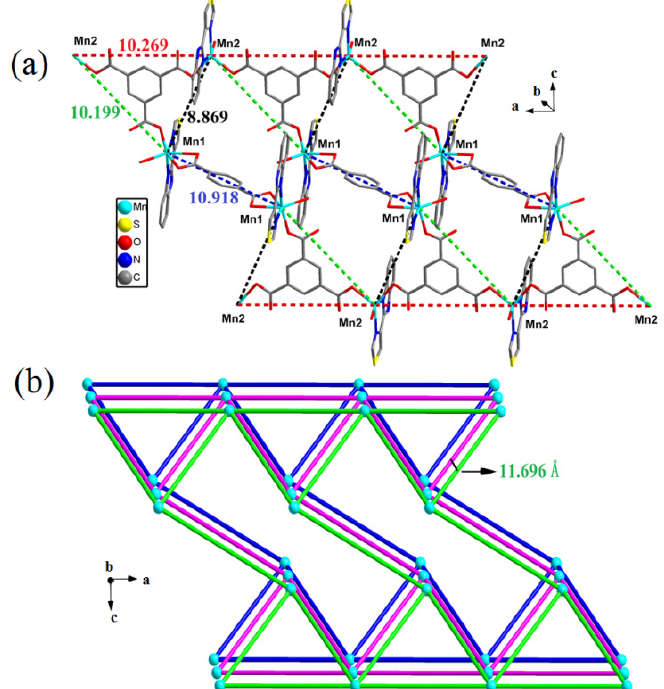
Figure 8. ( a ) Perspective view of 2-D network. ( b ) Schematic illustration of offset stacking of adjacent three 2-D single layers in compound 2 . (Color code: blue,